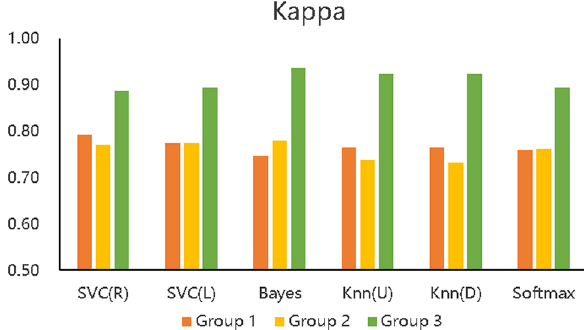
Figure 7. Kappa of the three types of prediction models.